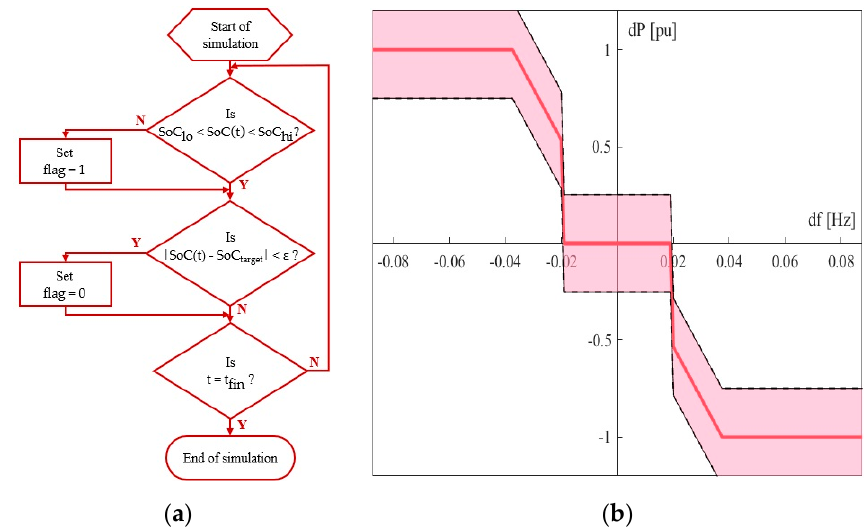
Figure 7. Schematic representation of available energy DoF case: ( a ) flow diagram for flag variable activation; ( b ) droop curve adopted. The red line is the reference droop curve without offset, to be kept while flag = 0. The pink area delimited by the black dashed lines represents the range of power setpoints that can be adopted in the case flag = 1. For a given dF, dP can vertically span within the pink zone between the black dashed lines. In the simulation, this is used to restore the SoC in the case of scarce or excessive energy content.